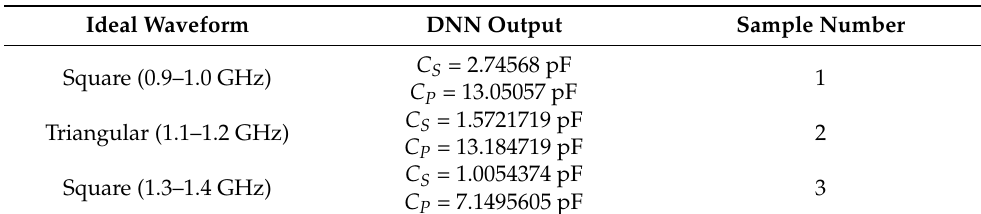
Figure 7. Comparison of results from ground truth and DNN output. Table 4. Capacitor values obtained from DNN for ideal inputs. Table 4. Capacitor values obtained from DNN for ideal inputs.